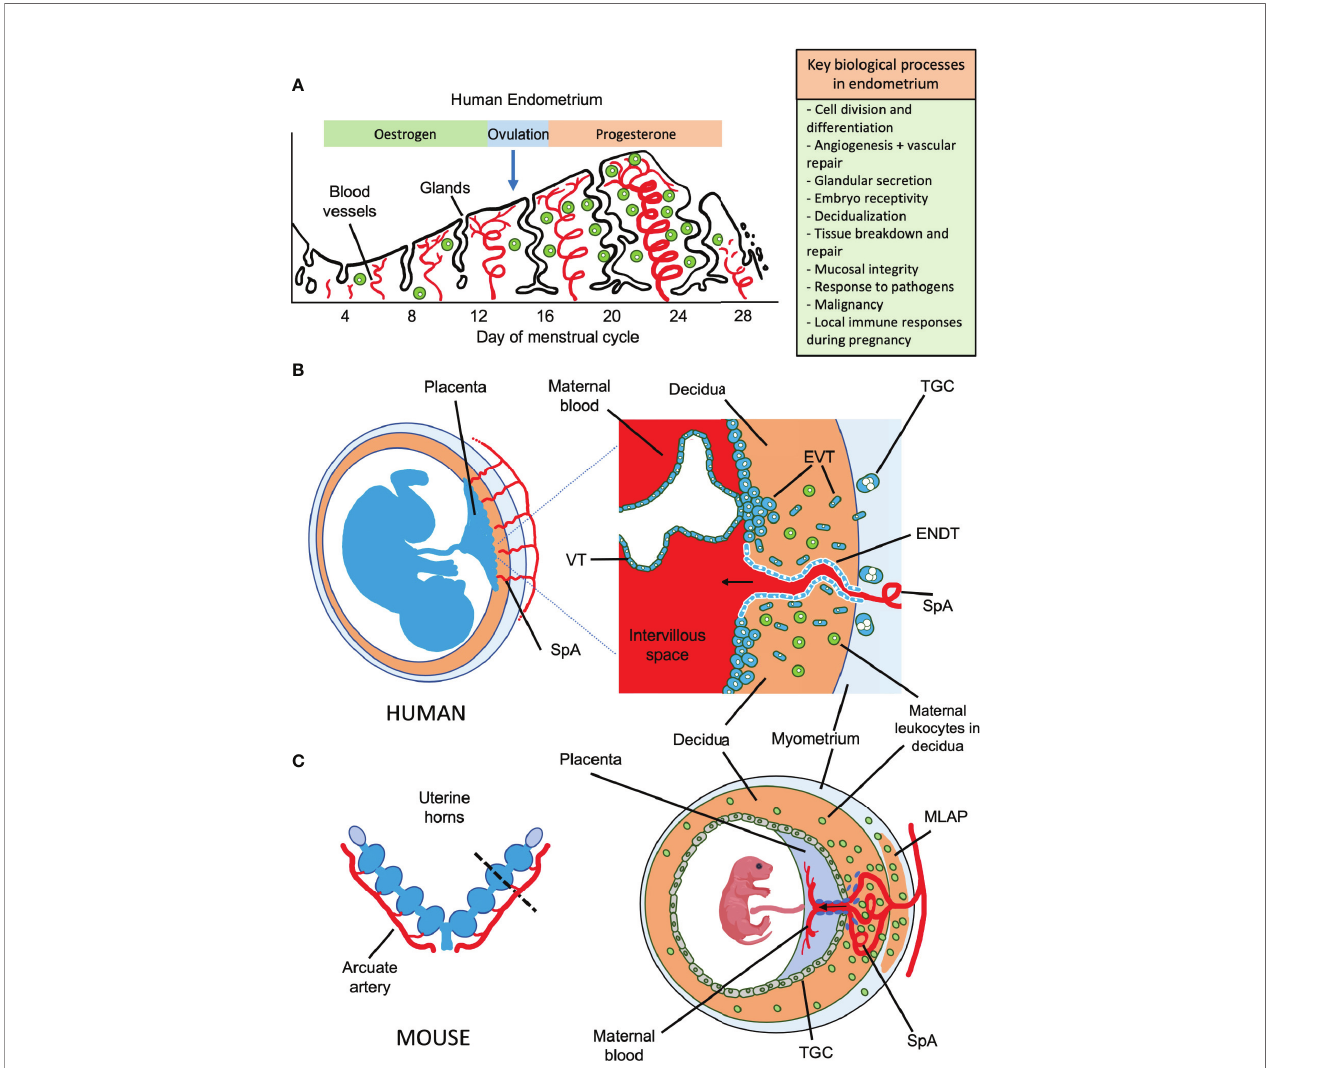
FIGURE 1 | Possible roles of uterine NK cells and ILCs in human endometrium and placental development in humans and mice. (A) Important biological processes in endometrium during the human menstrual cycle are shown, which may be in fl uenced by local immune cells. Following menstruation, the endometrium undergoes repair and proliferation under the in fl uence of oestrogen from the ovary and blood supply is re-established involving both spiral arterioles and new capillaries. Following ovulation, progesterone action results in decidualization of the endometrial stroma and a rapid increase in the number of uNK cells, which comprise up to 70% of the leukocytes (shown in green) towards the end of the cycle. Dynamics of other ILC populations in human endometrium through the cycle are less well understood. Murine endometrium cycles by exposure to oestrogen then progesterone but the estrous cycle only lasts ~5 days and there is no menstruation. (B) The human maternal-fetal interface. Spiral arterioles (SpA) branch from the radial arteries and penetrate the decidua to supply the placenta. Right hand panel shows placental villi bathed in maternal blood which enters the intervillous space. Placental villi are covered by syncytiotrophoblast, beneath which is the villous cytotrophoblast layer (VT). Anchoring villi attach to decidua via columns of extravillous trophoblast (EVT) which differentiates from VT. Some EVT migrates down spiral arteries as endovascular trophoblast (ENDT) while other EVT cells migrate into the decidua as far as the myometrium where they transform into trophoblast giant cells (TGC). Interstitial EVT home to maternal spiral arteries and participate in their remodelling to provide a low pressure, high capacity blood supply to the placenta. During the fi rst half of pregnancy, when spiral artery remodelling occurs, trophoblast invasion in humans is much deeper and more extensive than in mice. EVT invading into the decidua encounter maternal leukocytes (shown in green). In humans in the fi rst trimester, these comprise: ~70% NK and ILCs, 20% macrophages and ~10% T-cells, which include CD4 and CD8 cells. Figure (B) adapted from Moffett and Colucci (1). (C) Schematic view of pregnant mouse uterus showing multiple implantation sites. Radial arteries branch from the arcuate artery to supply each developing fetus. The right hand panel shows a uterine cross section cut as indicated by the dotted line, with the arrangement of the placenta and decidua at gestation day (gd) ~12.5. The radial arteries penetrate through the myometrium, traversing a specialized structure that develops around mid-gestation, known as the mesometrial lymphoid aggregate of pregnancy (MLAP). The MLAP is not present in humans. Spiral arteries (SpA) branch from the radial artery into the decidua, rich in uterine NK cells but then merge at the interface between the placenta and the decidua to form a large blood canal that supplies the labyrinthine layer of the placenta where gaseous exchange takes place between maternal and fetal blood. This blood canal is lined with specialized fetal trophoblast cells (shown coloured purple). The boundary between the placenta and decidua is delineated by trophoblast giant cells (TGC), which show minimal invasion into the decidua - those few that do invade are largely perivascular. From gd12.5, glycogen rich trophoblast cells invade more extensively into the decidua (later than timepoint shown here), but spiral artery remodelling is largely complete by gd12.5. Panel C based on data from Adamson et al.